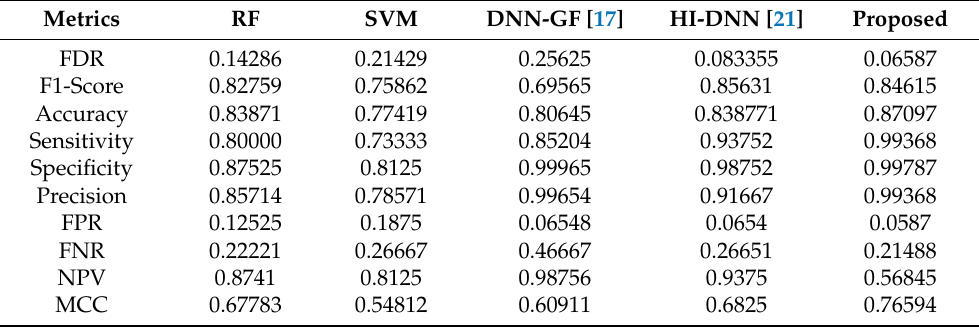
Table 9. Classification Results with